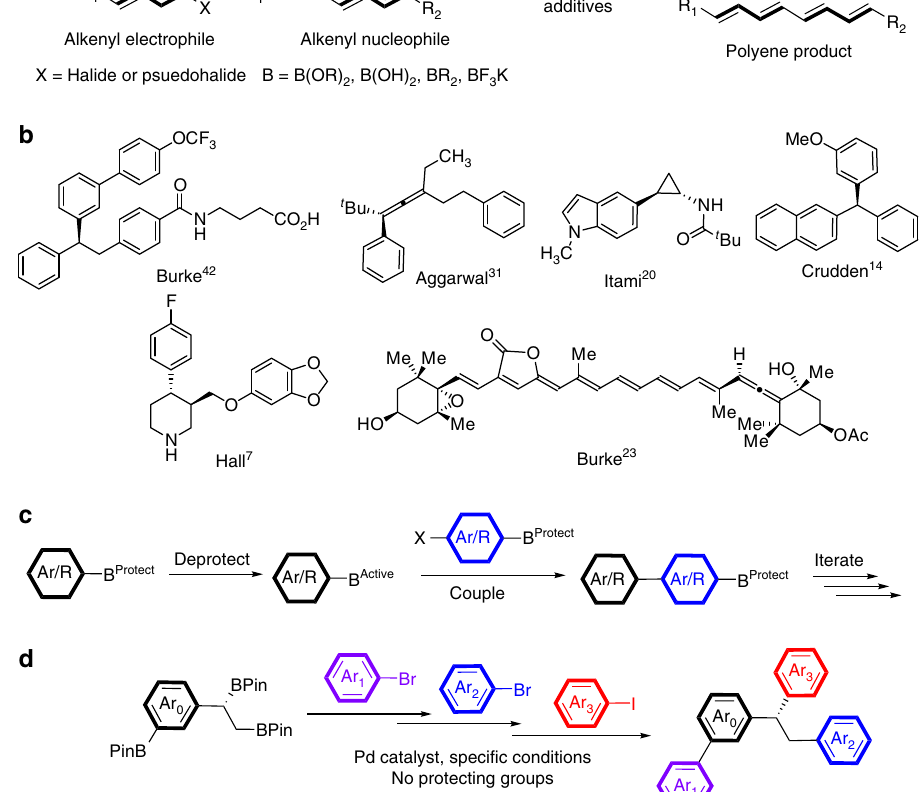
Figure 1 | Advances in the Suzuki–Miyaura cross-coupling reaction. ( a ) Classical Suzuki–Miyaura reaction for the formation of C–C bonds between aryl or alkenyl electrophiles and aryl or alkenyl organoboron nucleophiles. ( b ) Selected examples of molecules prepared by enantiospecific Suzuki–Miyaura cross- coupling reactions. ( c ) Iterative coupling concept employing the Suzuki–Miyaura reaction as the key structure-building component. ( d ) This work: chemoselective, protecting group-free cross-coupling of multiply borylated organic compounds, including the coupling of chiral, enantioenriched B–C